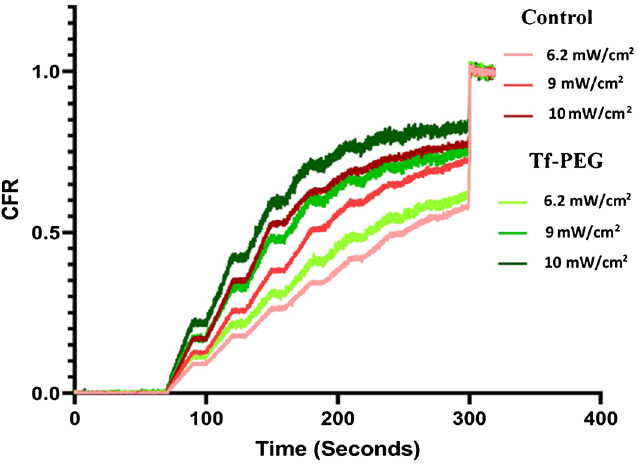
Figure 7. Normalized-averaged release profiles of 3 batches of control liposomes and Tf-PEG liposomes.